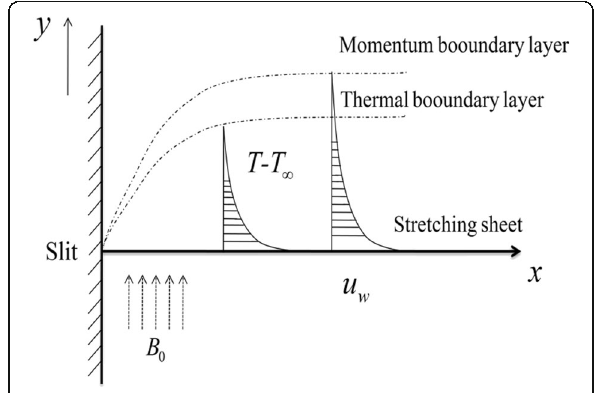
Fig. 1 Physical model of the flow and coordinate